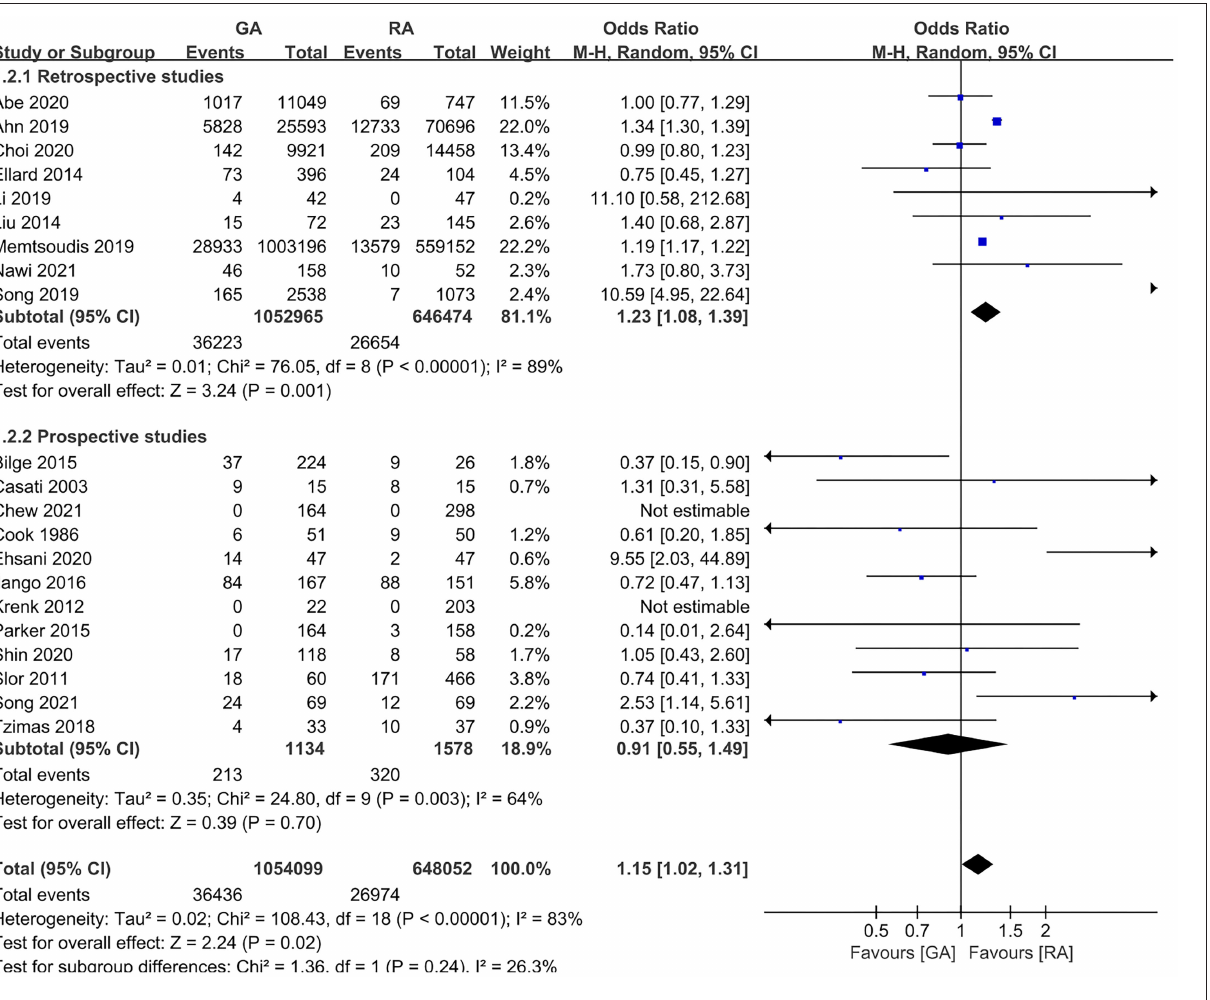
FIGURE 6 | The subgroup analysis according to study designs (retrospective and